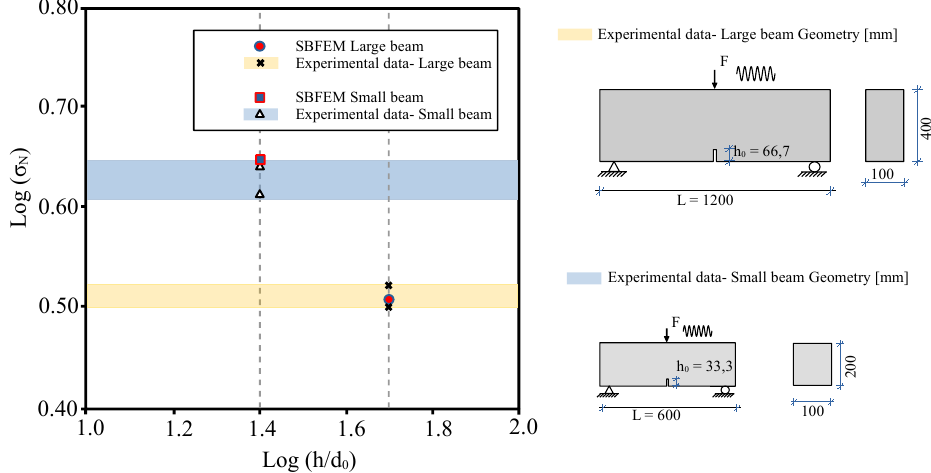
Figure 8. The effect of the size of the beam on the nominal strength under monotonic